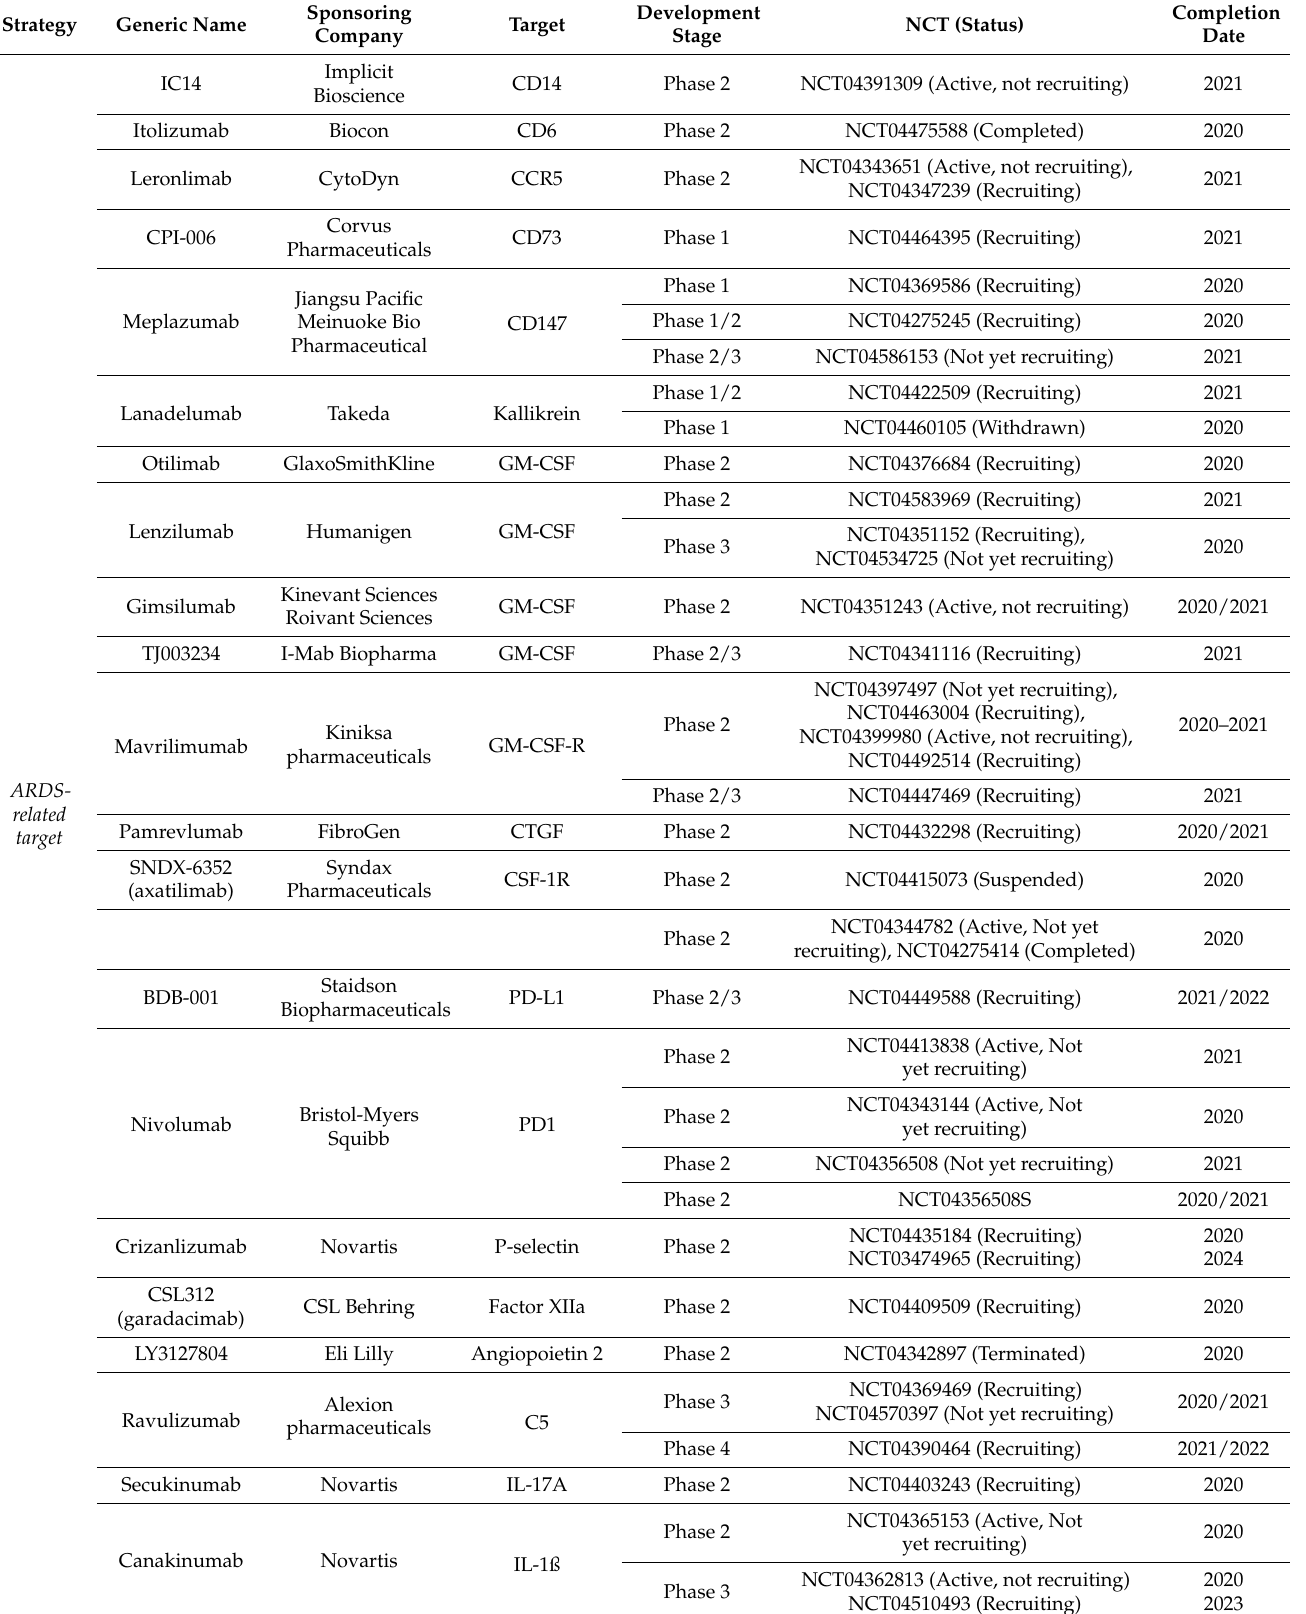
Table 3. Therapeutic antibodies for the COVID-19